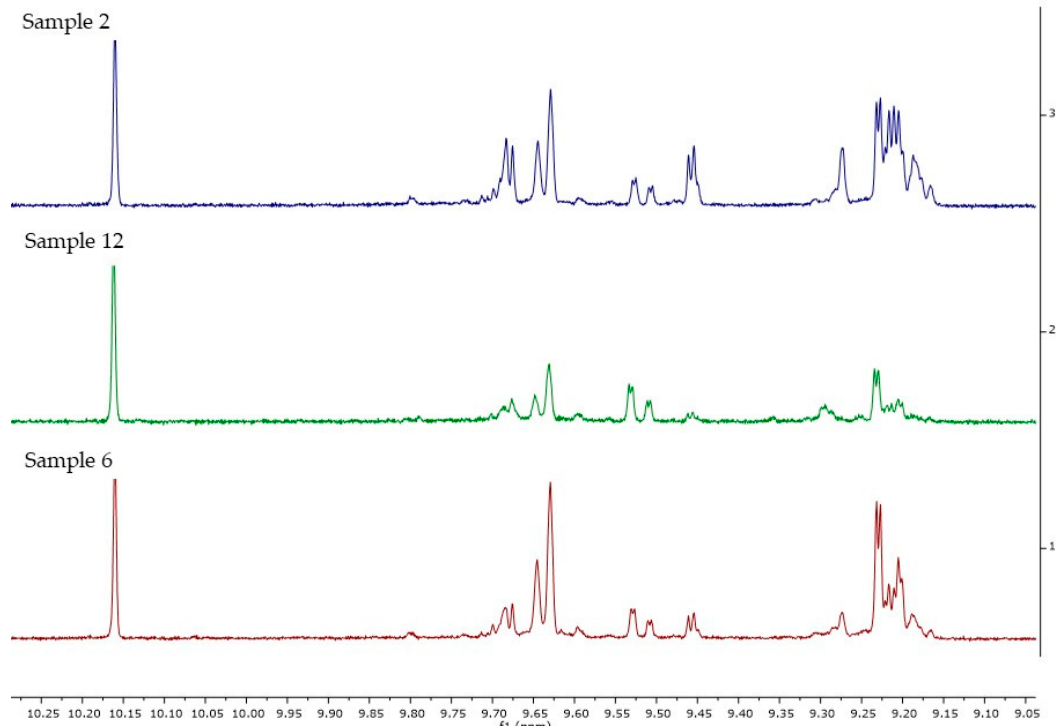
Figure 13. Enlargement of the aldehydic zone of 1 HNMR for samples 2, 6 and 12.